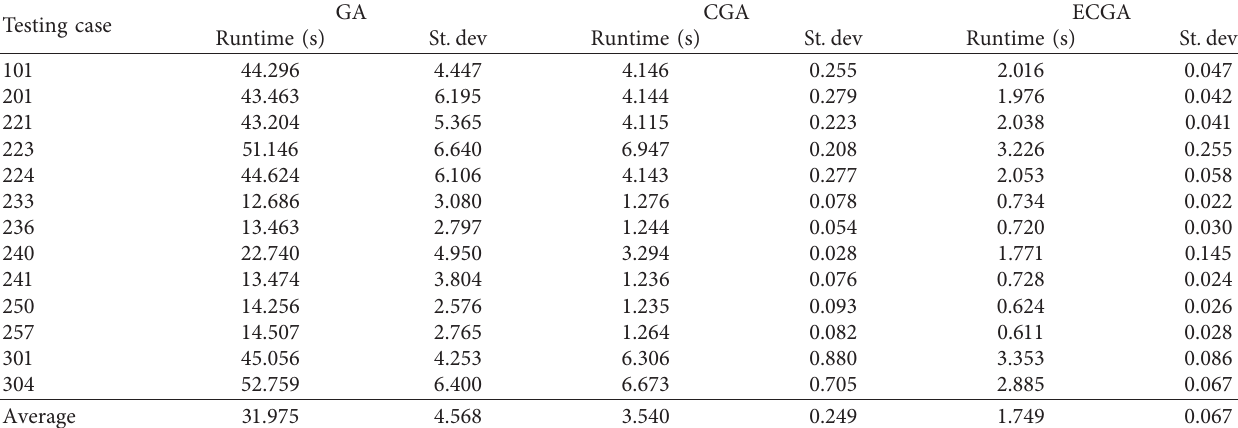
Table 6: Comparison of runtime and its standard